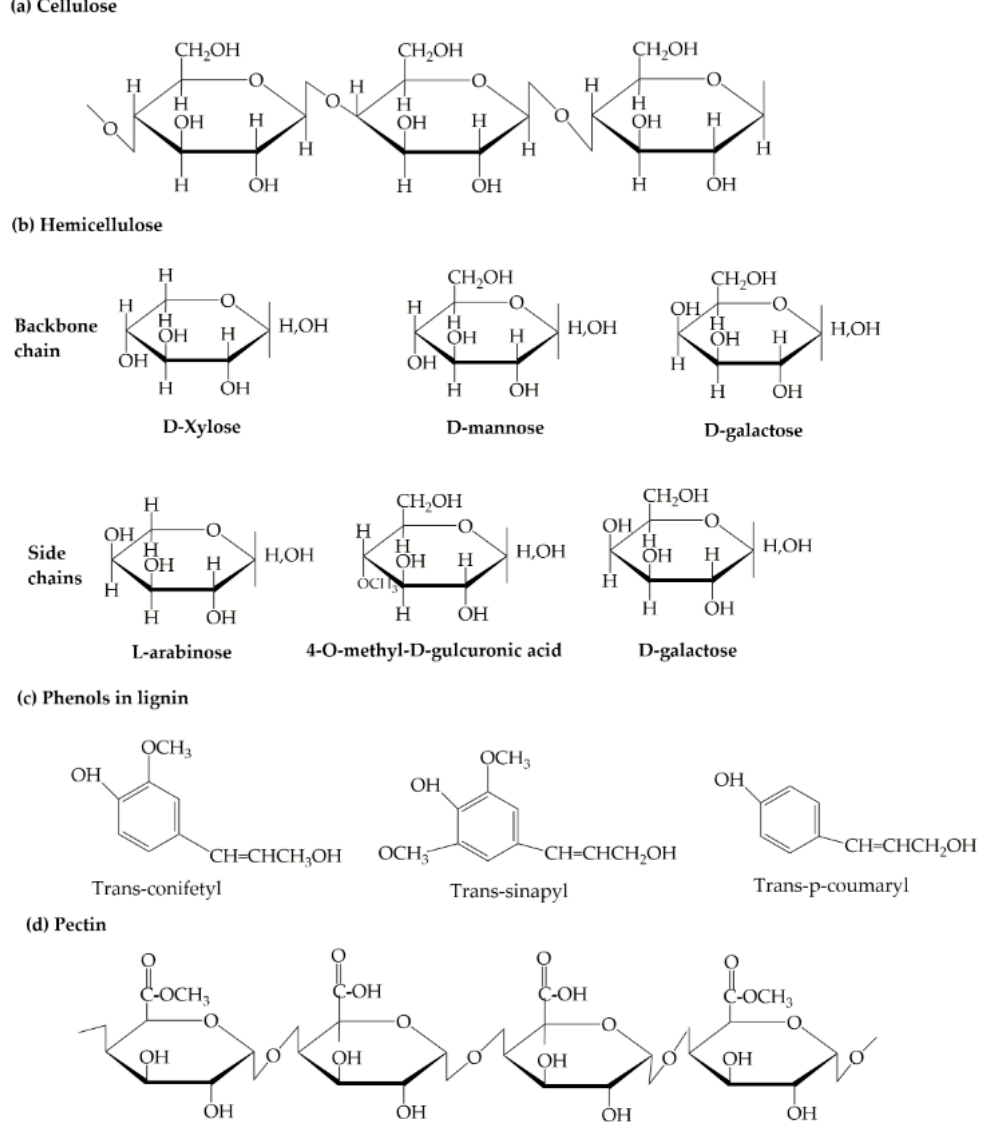
Figure 4. Di ff erent chemical structures of natural fibers: ( a ) Cellulose; ( b ) Hemicellulose; ( c ) Phenols in lignin; and ( d ) Pectin. Reproduced with permission from Elsevier [10]. Copyright Elsevier, 2015. Table 2. Chemical compositions of di ff erent natural fibers